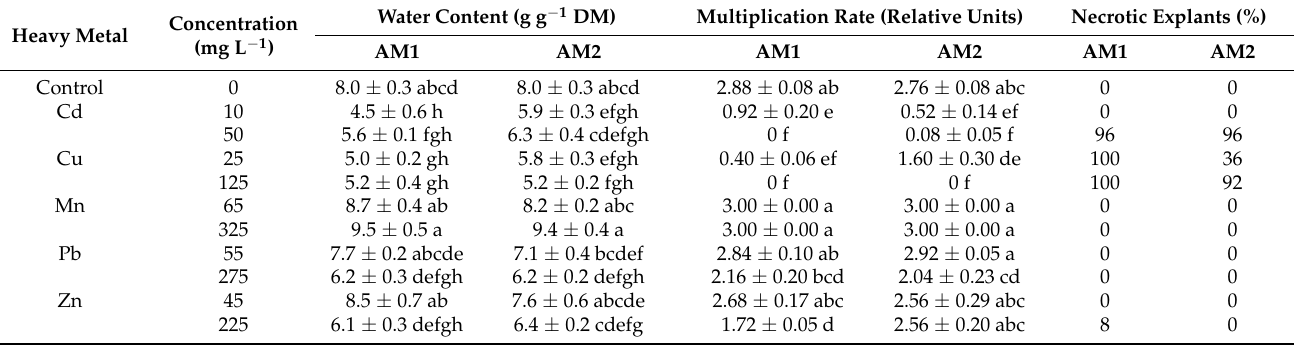
Table 3. Effect of heavy metals on plantlet water content, multiplication intensity, and percentage of necrotic explants of Armeria maritima accessions AM1 and AM2 after 4 weeks in tissue